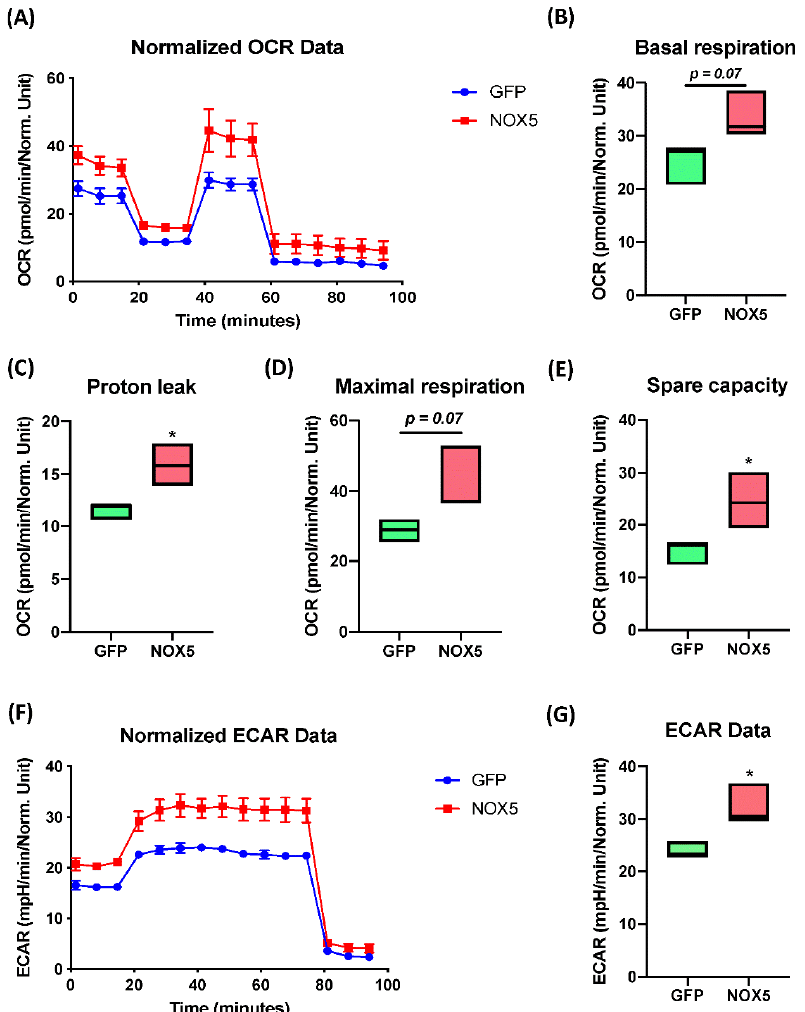
Figure 9. NOX5- β overexpression enhances mitochondrial capacity and activity, as well as non-glucidic metabolism in an Extended Mitostress assay in hCMEC/D3 cells. Data normalized by protein quantity. ( A ) Time course of the oxygen consumption rate (OCR) in GFP and NOX5-infected endothelial cells. Data are presented as: ( B ) cell basal respiration. ( C ) Proton leak. ( D ) Maximal cell respiration. ( E ) Spare capacity. ( F ) Time course of the extracellular acidification rate (ECAR) in GFP and NOX5-infected endothelial cells. ( G ) ECAR data. OCR: oxygen consumption rate; ECAR: extracellular acidification rate; GFP: GFP-infected hCMEC/D3 cells; NOX5: NOX5- β -infected hCMEC/D3 cells. ( n = 3) * p < 0.05 vs. GFP-infected cells. Data presented as floating bars from minimum to maximum, marking the